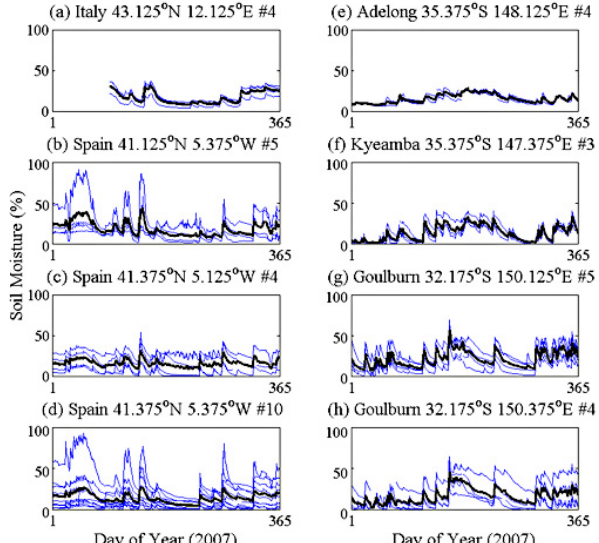
Fig. 1. Time series of in situ soil moisture for the eight 0.25 ◦ grid cells within which more than three (inclusive) in situ stations were located. Blue represents measurement from individual in situ sta- tions and black is the average value. Location, latitude and lon- gitude (center of the grid cell), and number of in situ stations are